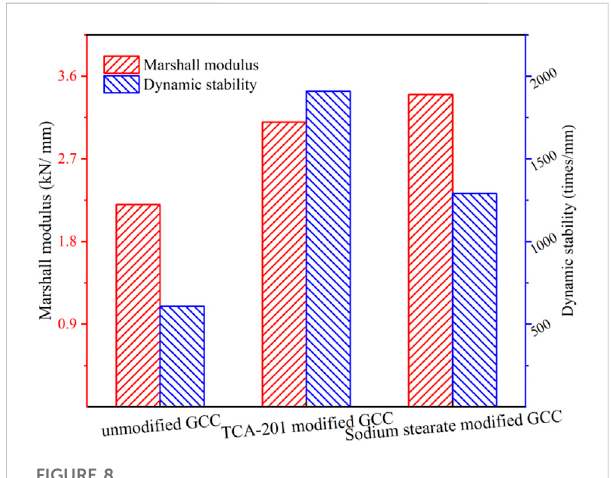
FIGURE 8 Result of AC-13C Marshall Stability Tests and wheel tracking test.